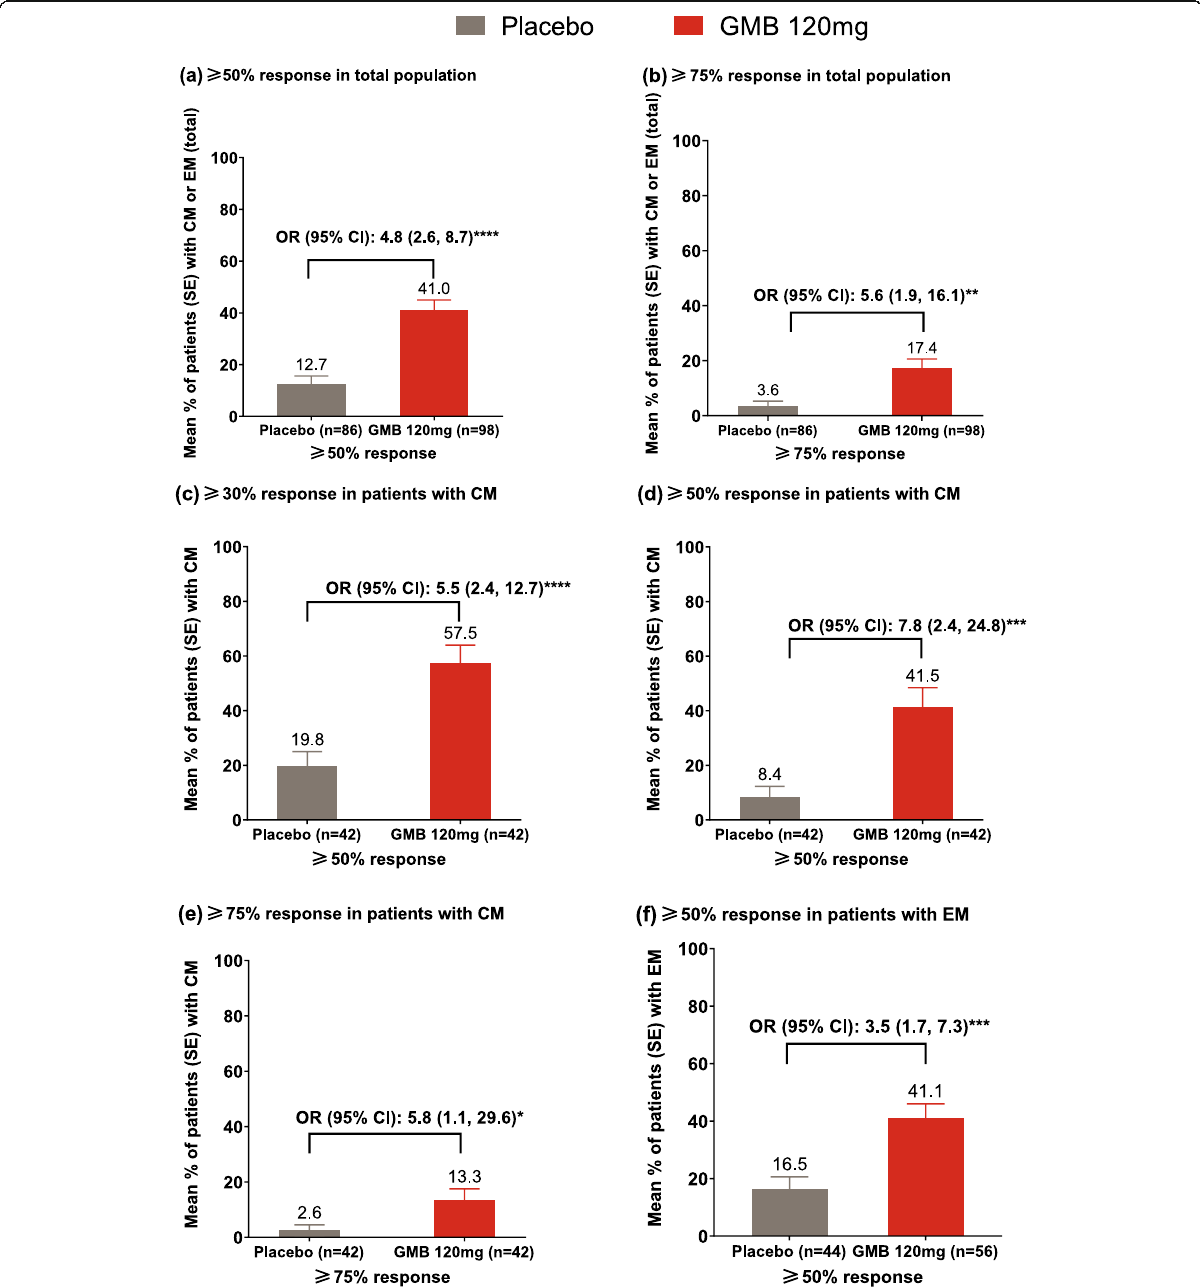
Fig. 2 Mean percentage of patients with: a ≥ 50% and b ≥ 75% reduction in monthly migraine headache days (total population) # ; c ≥ 30%, d ≥ 50%, and e ≥ 75% reduction in monthly migraine headache days in patients with CM # ; and f ≥ 50% reduction in monthly migraine headache days in patients with EM # . Note: Only 30% response for patients with chronic migraine was pre-specified and was included in this analysis. # Patients who had failed 3 – 4 preventive medication categories due to inadequate efficacy (after at least 2 months at maximum tolerated dose), or safety or tolerability reasons within the last 10 years. *** P ≤ .001, ** P ≤ 0.01, * P ≤ .05 versus placebo. CI: confidence interval; CM: chronic migraine; EM: episodic migraine; GMB: galcanezumab; LS: least squares; n: number of patients with non-missing baseline value and at least one post- baseline value; OR: odds ratio; SE: standard